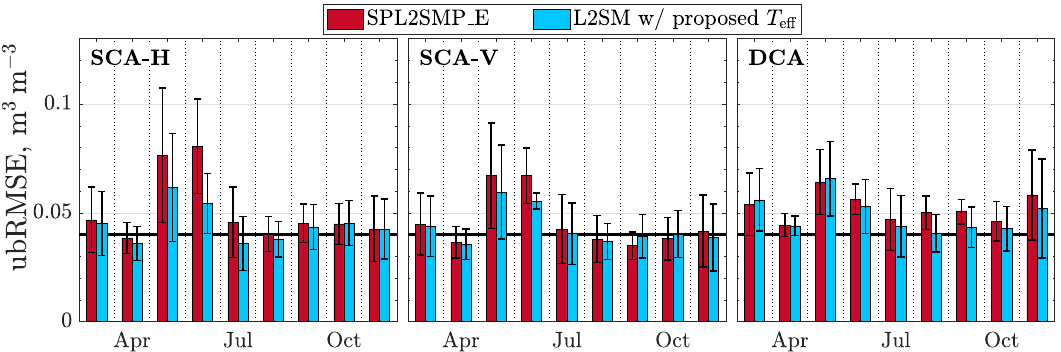
Figure 5. Mean and standard error of monthly bias for SMAP L2SM version 2 and that reprocessed using our proposed T eff in the South Fork during 2015–2018.